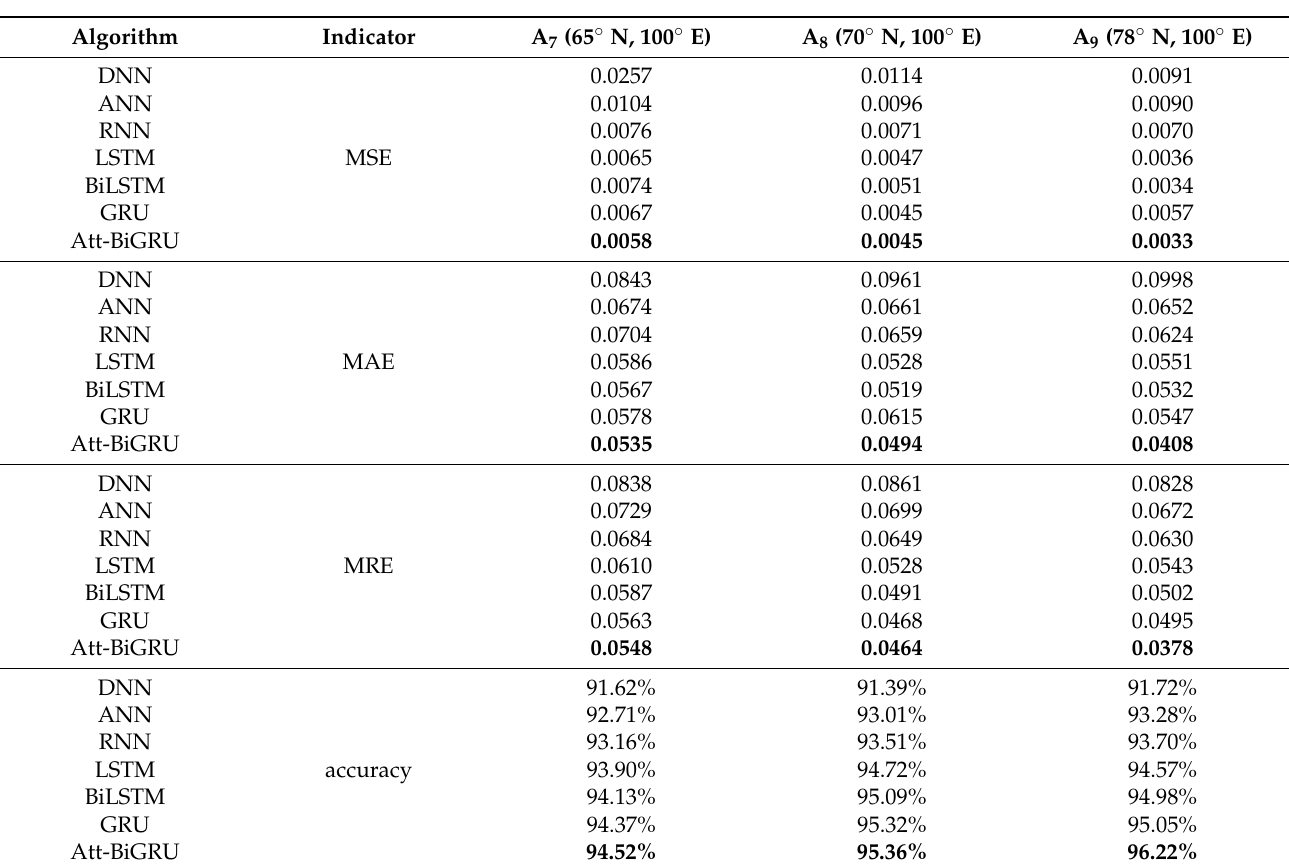
Table 8. Comparison of five methods in three high latitude